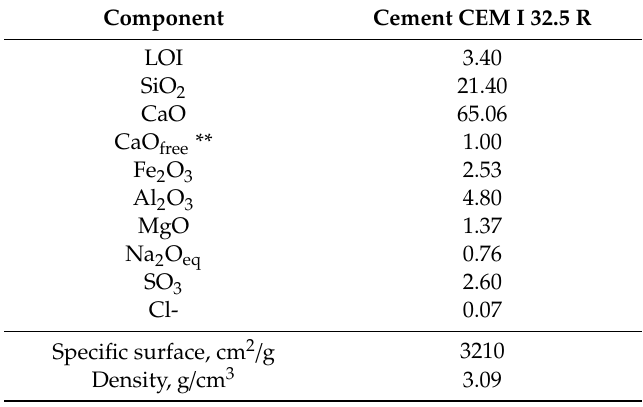
Table 2. Chemical composition and physical properties of cement, determined by XRF method (wt %).